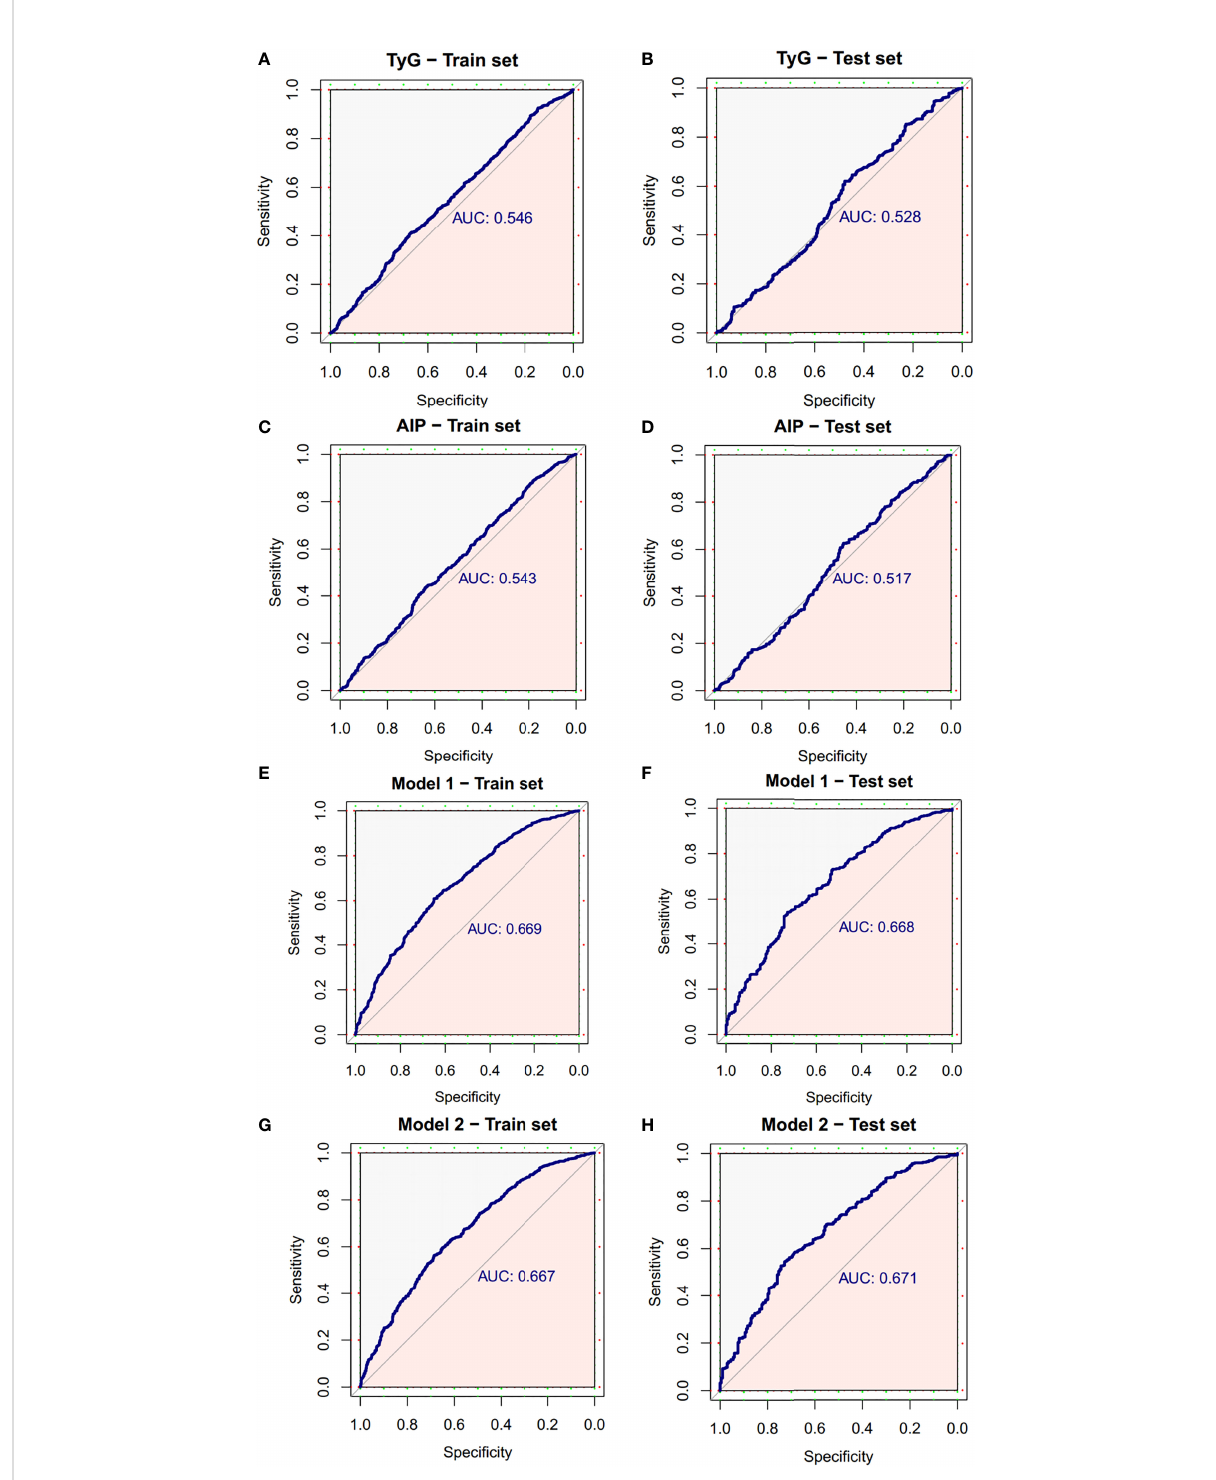
FIGURE 3 ROC curve of the diagnostic models for neoplasms. (A) ROC curve of the TyG index for diagnosis of neoplasms in train set. (B) ROC curve of the TyG index for diagnosis of neoplasms in test set. (C) ROC curve of AIP for diagnosis of neoplasms in train set. (D) ROC curve of AIP for diagnosis of neoplasms in test set. (E) ROC curve of model 1 for diagnosis of neoplasms in train set. (F) ROC curve of model 1 for diagnosis of neoplasms in test set. (G) ROC curve of model 2 for diagnosis of neoplasms in train set. (H) ROC curve of model 2 for diagnosis of neoplasms in test set. AUC, area under the curve; CI, con fi dence interval; ROC, receiver operating